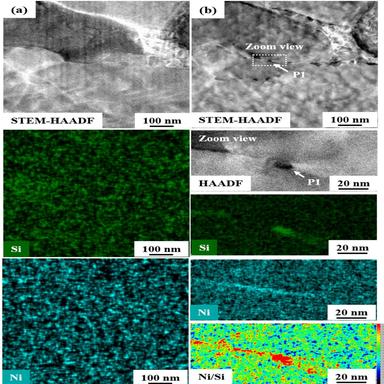
STEM-HAADF micrographs and corresponding elemental maps of Fe, Cr, Mn and C were collected at the same area of HT9 (a) before and (b) after ion irradiation to 20 dpa at 440 °C. The zoom view of panel (b) highlights the formation of (Cr, Mn)-rich carbides at the grain boundary. One of these carbides (labeled as P2) is further observed in. (two columns wide).